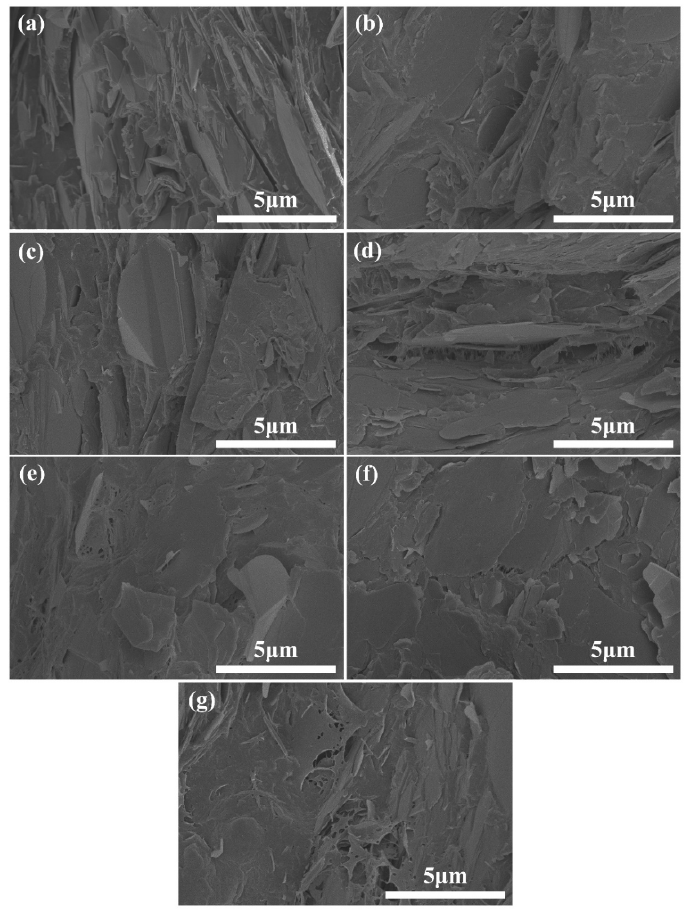
Figure 2. FESEM graphs of etched composites of ( a ) PA6/BN, ( b )PA6/BN/SA1, ( c ) PA6/BN/SA2, ( d ) PA6/BN/SA3, ( e ) PA6/BN/SA4, ( f ) PA6/BN/SA5, and ( g ) PA6/BN/SA6.